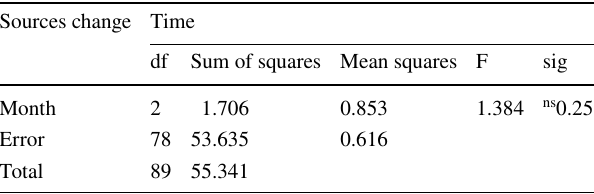
Table 1 The results of the variance analysis test of falling dust between the months and places in spring